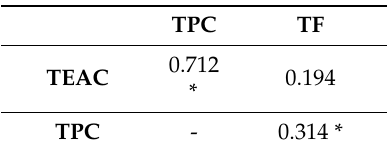
Table 1. Pearson’s correlation coefficients between antioxidant capacity (TEAC), phenolic compounds (TPC) and total flavonoids